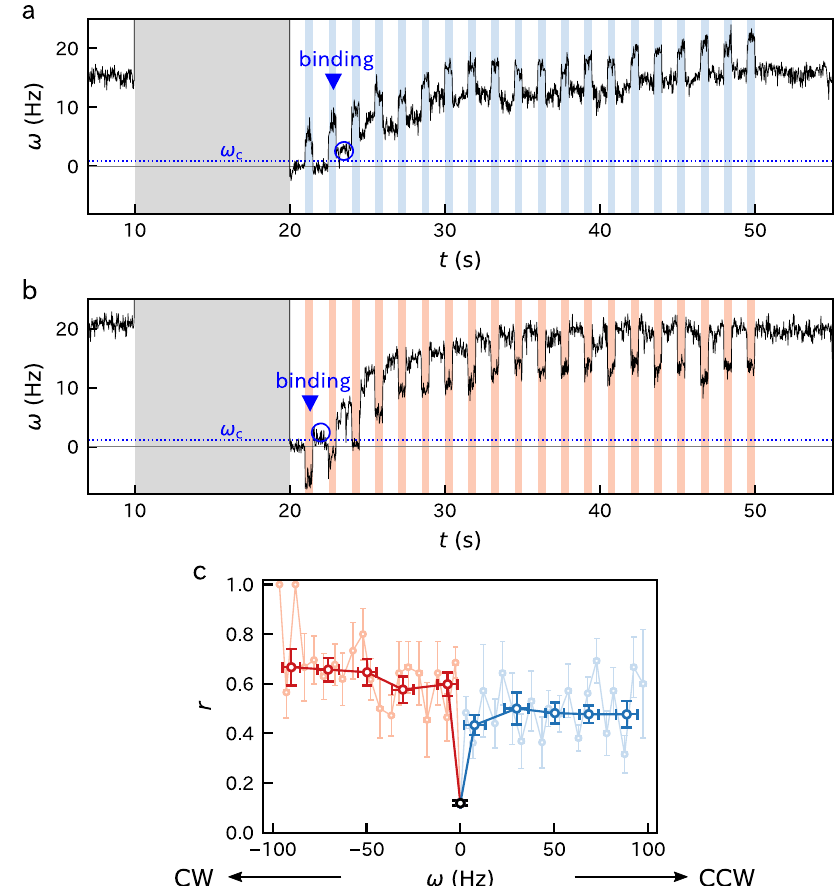
Fig. 4 Evaluation of rotation-dependent binding rate using pulse-wise forced rotation. The alternation of 0.5-s ON (shaded by blue or red) and 1-s OFF of the external torque was induced in assisting direction ( a ) or hindering direction ( b ). When ω exceeded ω c (cid:3) ω max = 20, we assumed that the fi rst stator unit bound. c , Binding rate as a function of the forced rotation rate averaged in bins with the width of 20 Hz (dark) superposed on that with 5-Hz bins (light). We used 396 traces of 122 cells in total. See Supplementary Fig. 8 for details. Data are presented as mean values± standard errors.